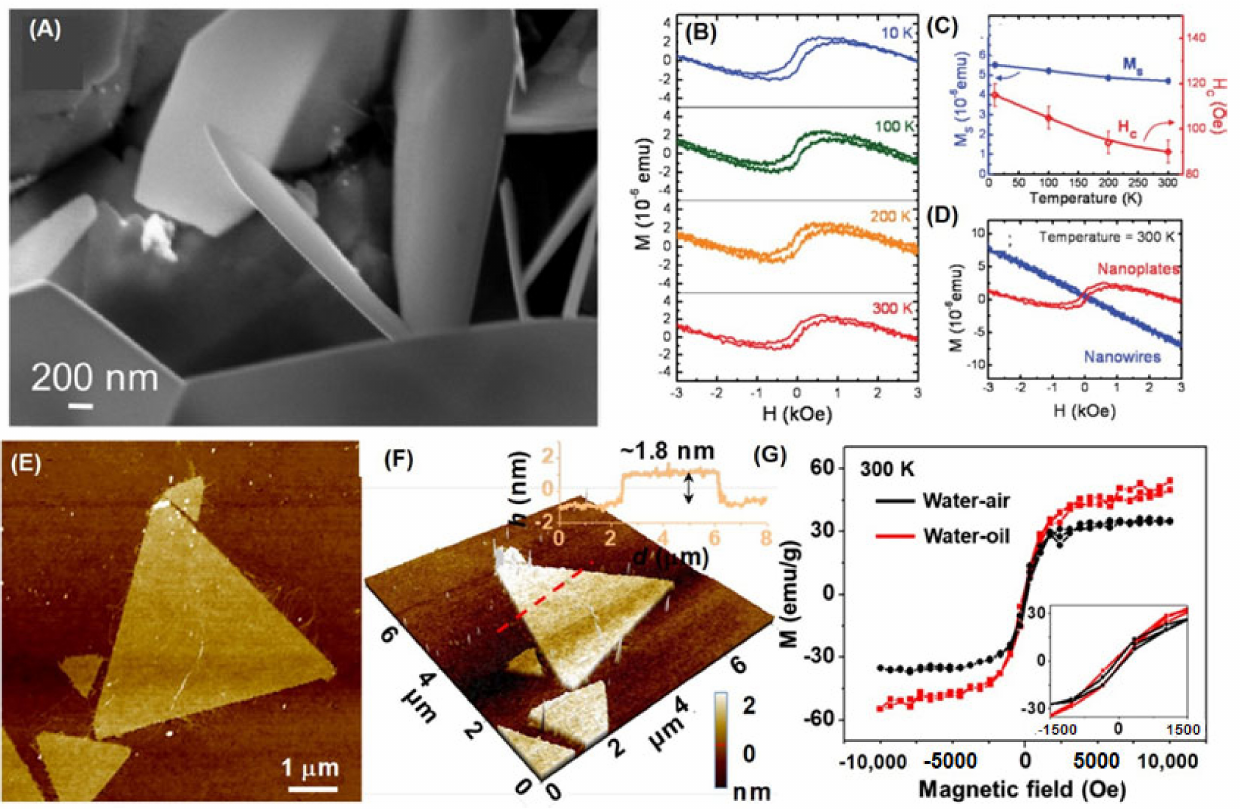
Figure 9. ( A ) ZnO nanoplates synthesized by HYT. ( B ) M–H curves for ZnO nanoplates. ( C ) The corresponding M s and coercivities H c are plotted in ( A ). ( D ) M–H curves for ZnO nanowires and nanoplates (Reproduced with permission from [82]. Copyright 2012, American Chemical Society). ( E , F ) AFM images of two-dimensional (2D) ZnO nanosheets by ILE. ( G ) M-H curves for 2D ZnO nanosheets (Reproduced with permission from [41]. Copyright 2019, American Chemical Society).